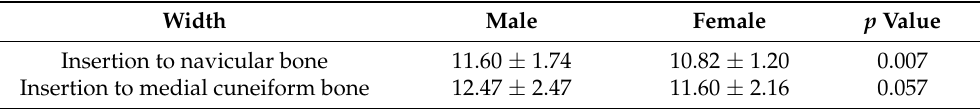
Table 5. The width of the insertion of the main tendon of the tibialis posterior ( n = 109).